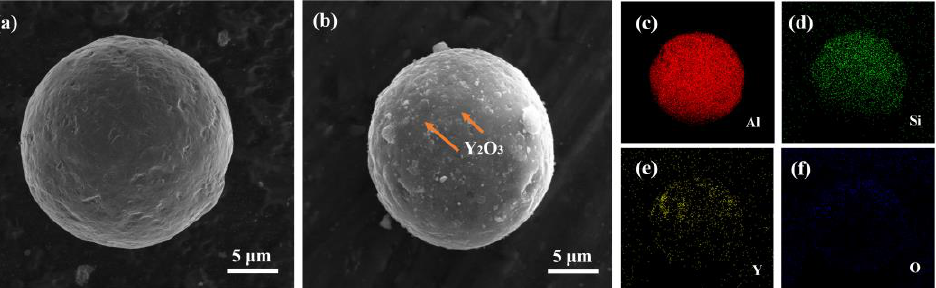
Figure 2. SEM image showing the morphology of ( a ) AlSi10Mg power and ( b ) 0.5 wt.% Y 2 O 3 - AlSi10Mg power. The orange arrows point to the Y 2 O 3 nanoparticles. EDS mapping showing the elemental distribution of ( c ) Al, ( d ) Si, ( e ) Y, and ( f ) O on the particle surface.